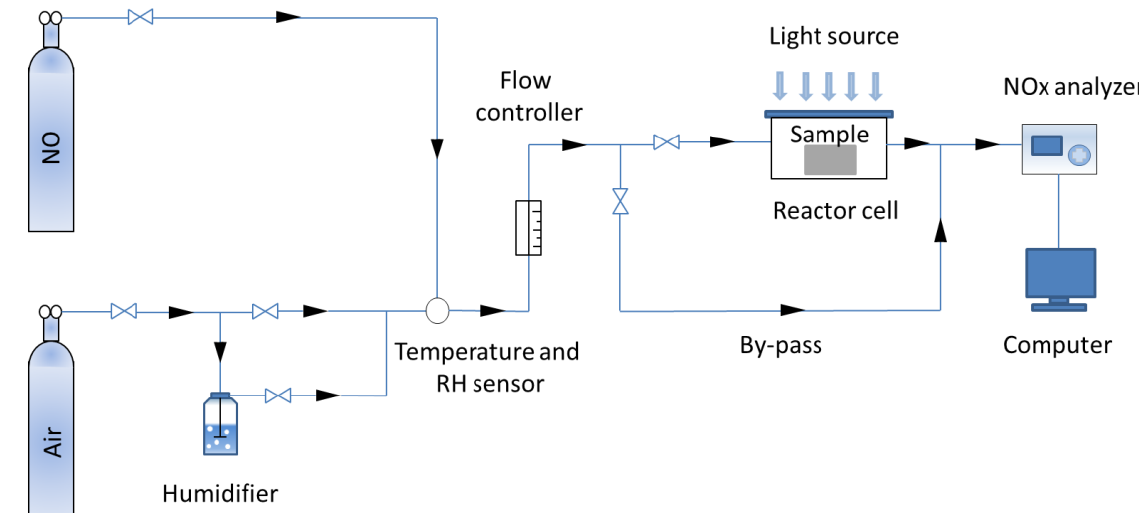
Figure 15. Schematic diagram of the NO x degradation reaction device.